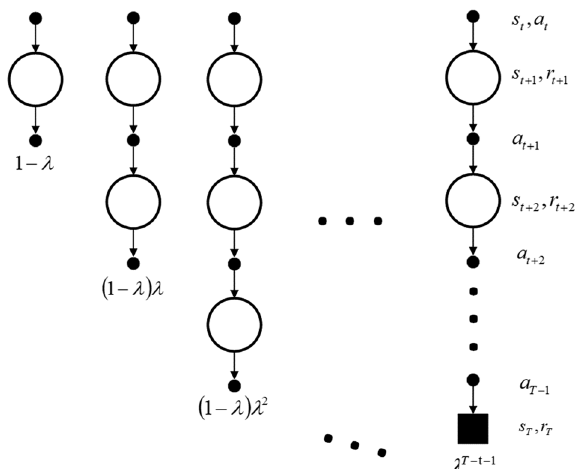
Fig. 4 Action trajectory diagram of Sarsa( (cid:31) ). The state-action trajectory diagram of the Sarsa( (cid:31) )